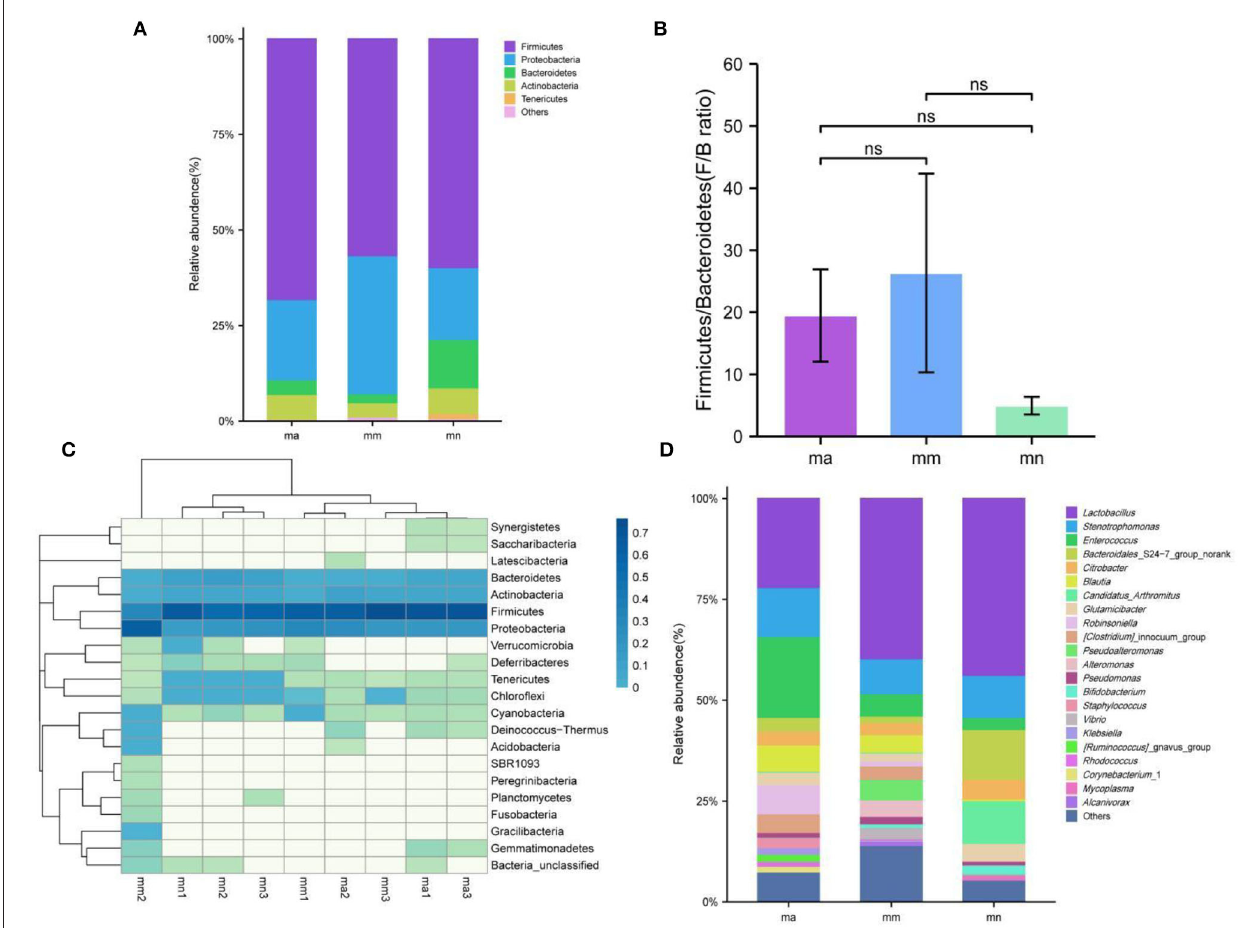
FIGURE 6 | Effect of QWBZP crude polysaccharide on the relative abundance of intestinal mucosal bacteria. mn, normal group; mm, model group; ma, QWBZP crude polysaccharide treatment group. (A) Relative abundance at the phylum level. (B) Histogram of Firmicutes/Bacteroidetes ratio. (C) Heat map of relative abundance at the phylum level. (D) Relative abundance at the genus